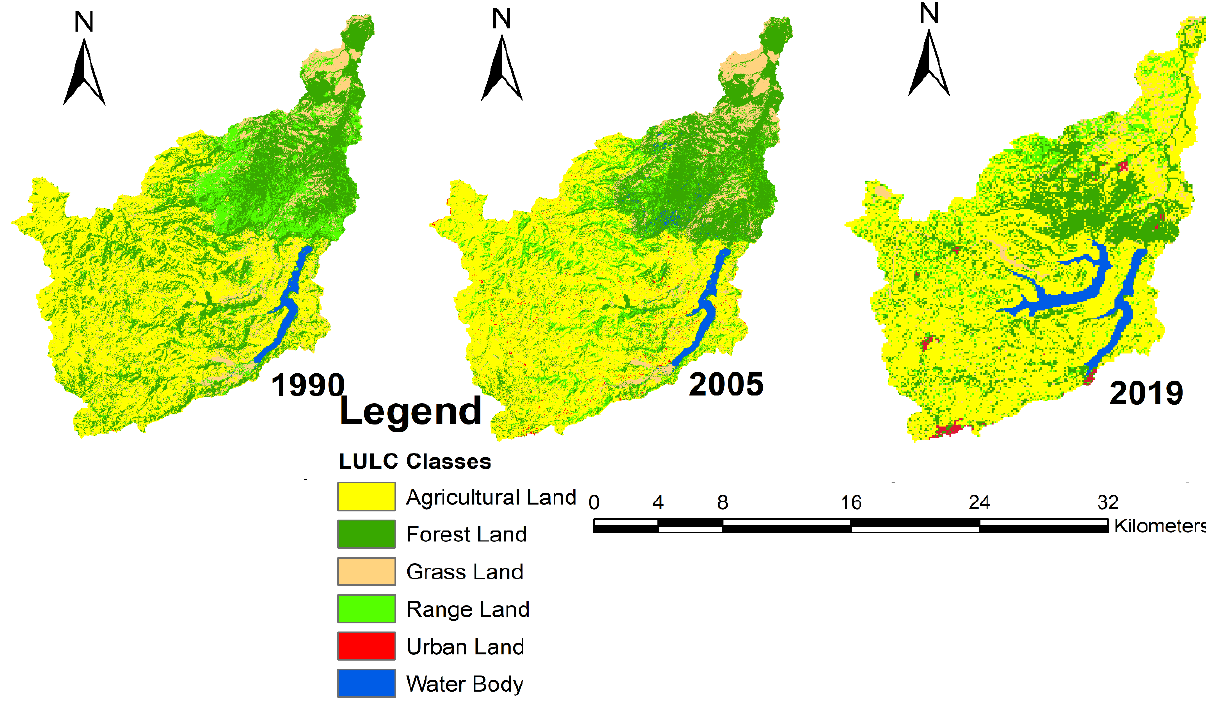
Figure 2. Current and historical land use land cover of the Nashe watershed.